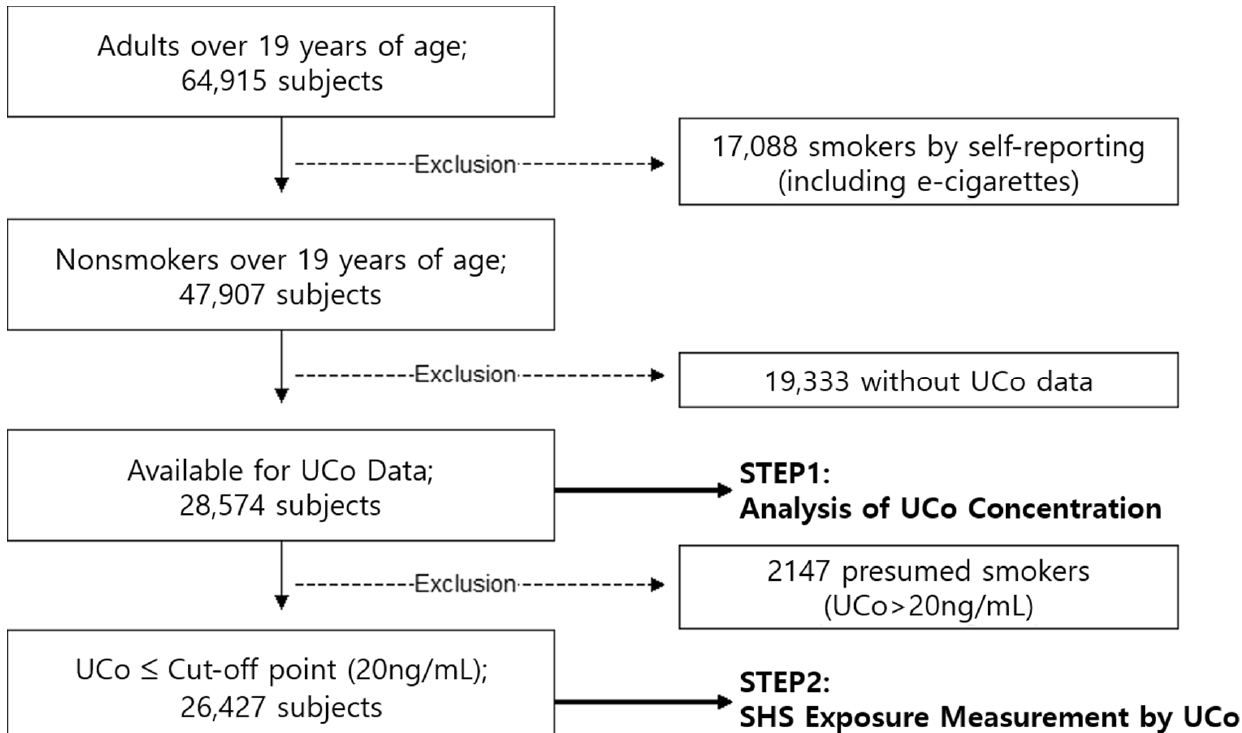
Figure 1. Flowchart of subjects in this study.